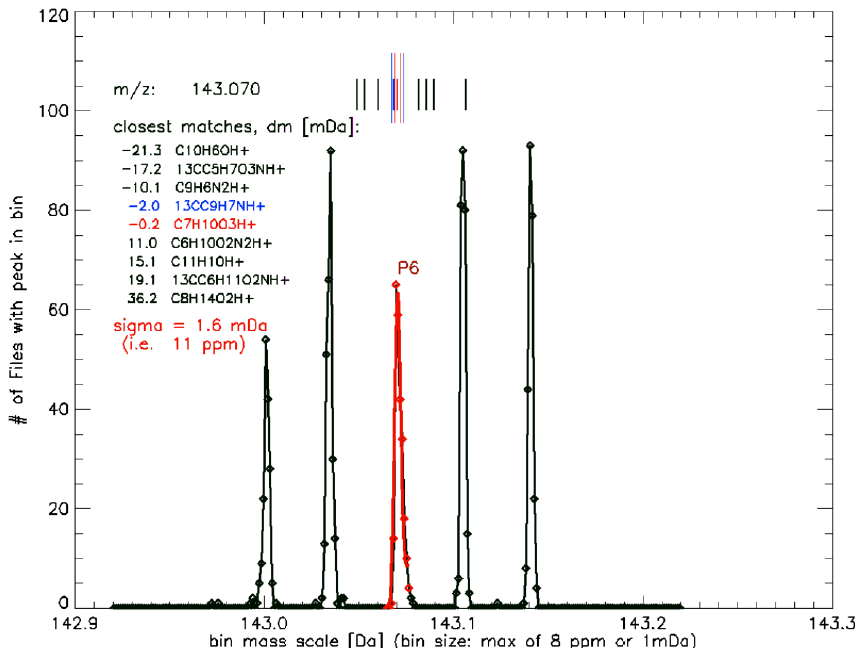
Figure 5. Histogram of peak detections in 8ppm mass bins in the range 142.92–143.22Da. More than 300 peak lists from individual files each covering a period of 75min have been included; i.e., the data are from a ∼ 2-week field campaign. The precision of a peak at 143.070 has been determined as σ (standard deviation) of a Gaussian fit. The red markers are the 11 points that have been fitted, and the red line shows the Gaussian fit. The long red and blue vertical lines above the peak mark the ± 1 and ± 2 σ boundaries, respectively. The short vertical lines mark the position of close matches with compounds in the library (also plotted in the chart area). Compounds plotted in red and blue correspond to compounds that are within ± 1 and ± 2 σ ,